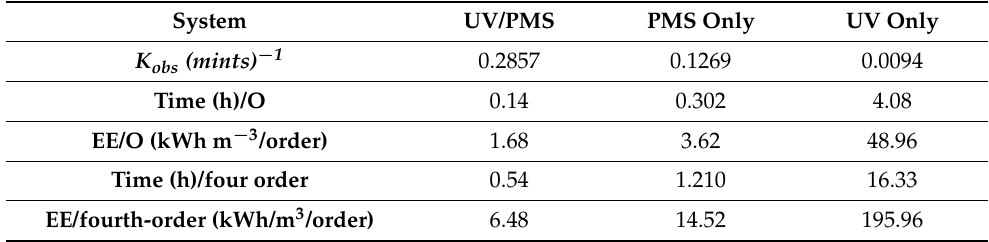
Table 1. Electrical energy comparison of UV and UV/PMS processes for removal of CV. Experimental